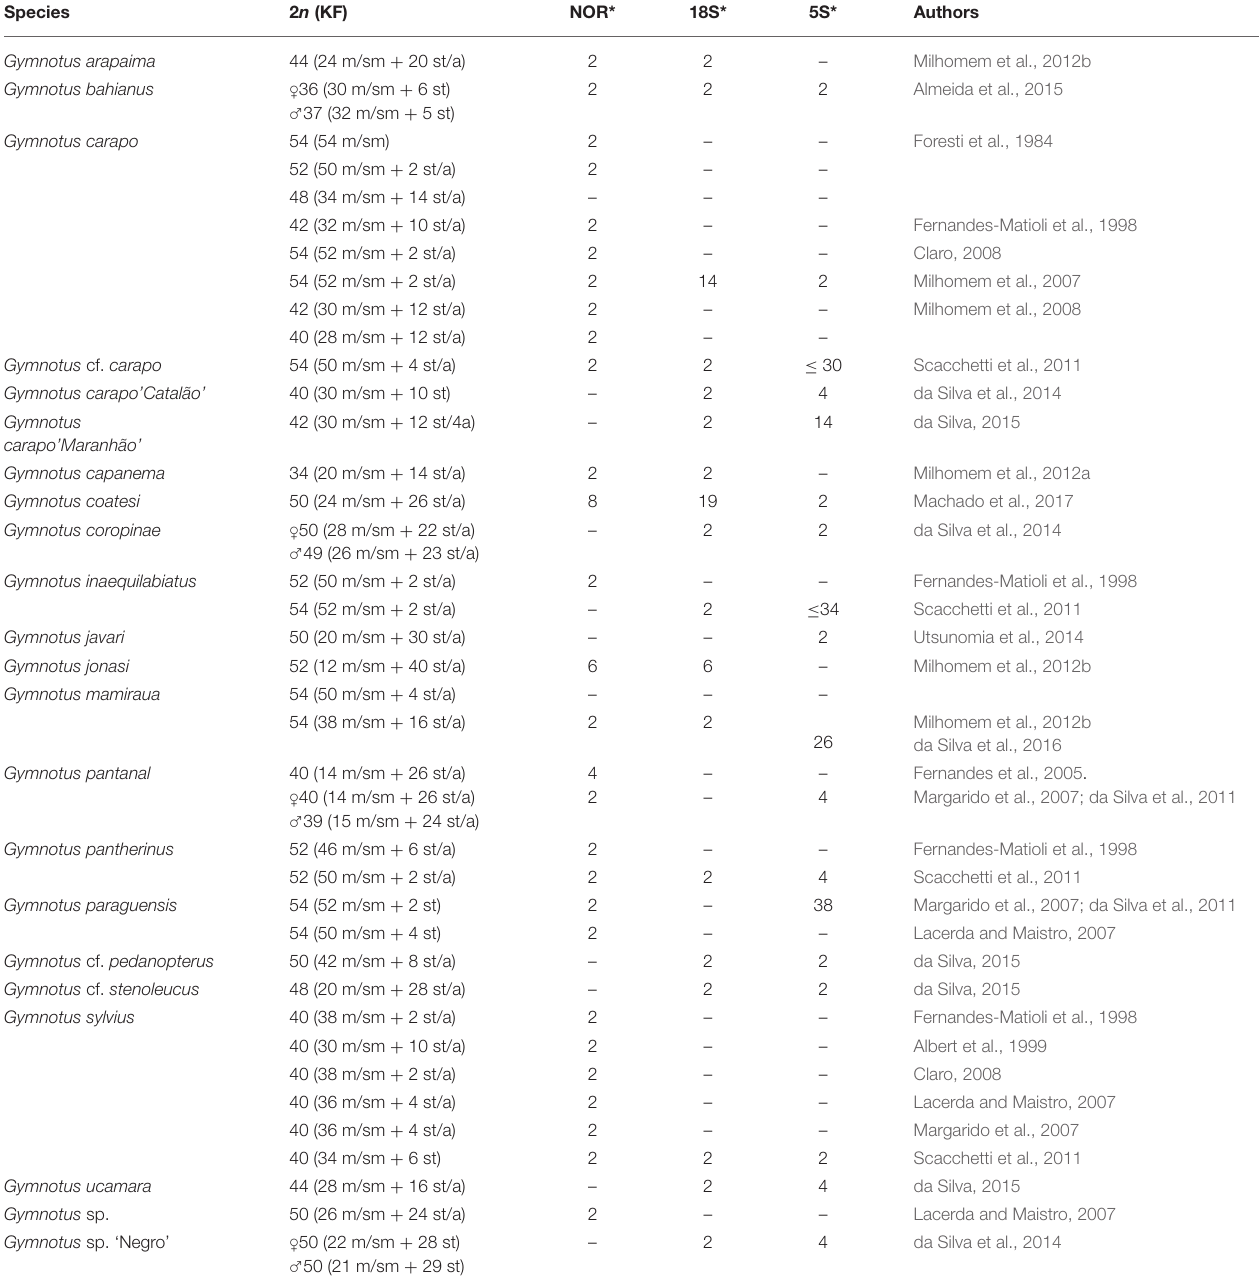
TABLE 1 | Cytogenetic data from the genus Gymnotus , including 2 n , karyotype formula (KF), NOR and ribosomal DNA sequences 18 and 5S.